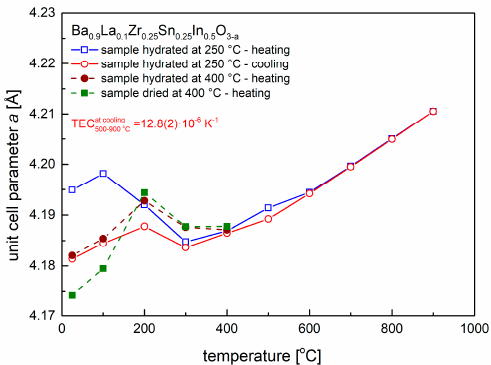
Figure 5. Unit cell parameter dependence on temperature, as calculated from high-temperature XRD data, recorded in synthetic air for samples, which were previously hydrated at 250 °C and 400 °C, as well as dried at 400 °C.